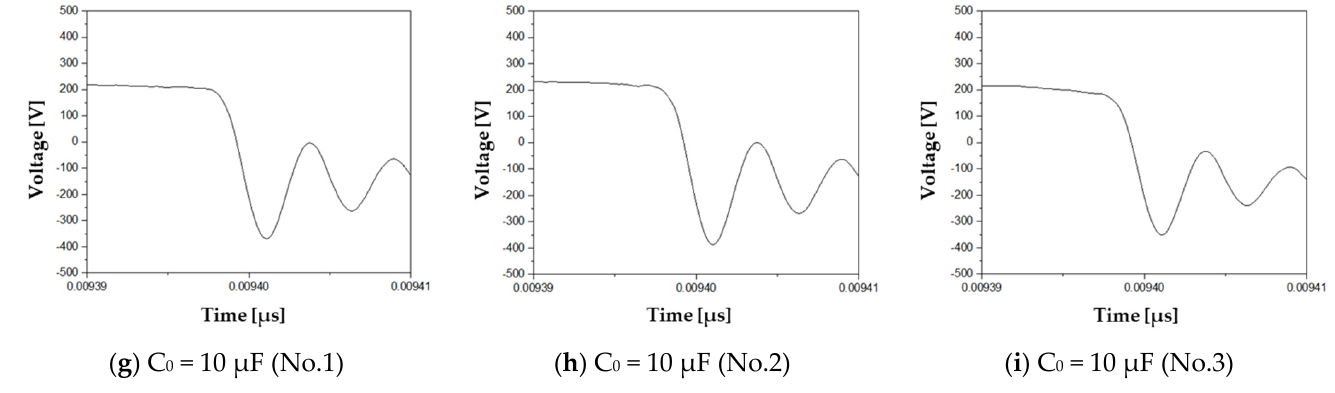
Figure 12. Dielectric recovery voltage at 45 °C.